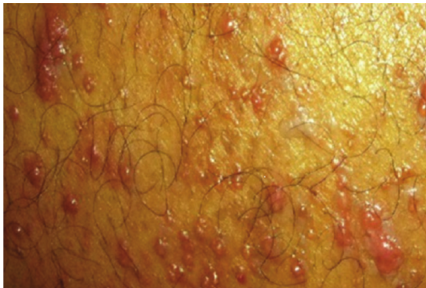
Figure 3: Hematoxylin and eosin staining of a 4 millimeter papule on the right lower extremity. Note the glandular structure of metastatic adenocarcinoma (arrow) with a desmoplastic reaction in surrounding tissue of the dermis